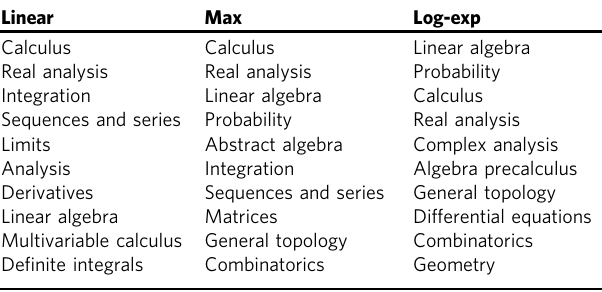
Table 1 Top ten nodes in the math stackexchange co-tags